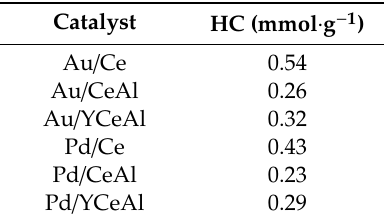
Table 3. Experimental H 2 consumption during TPR up to 300 ◦